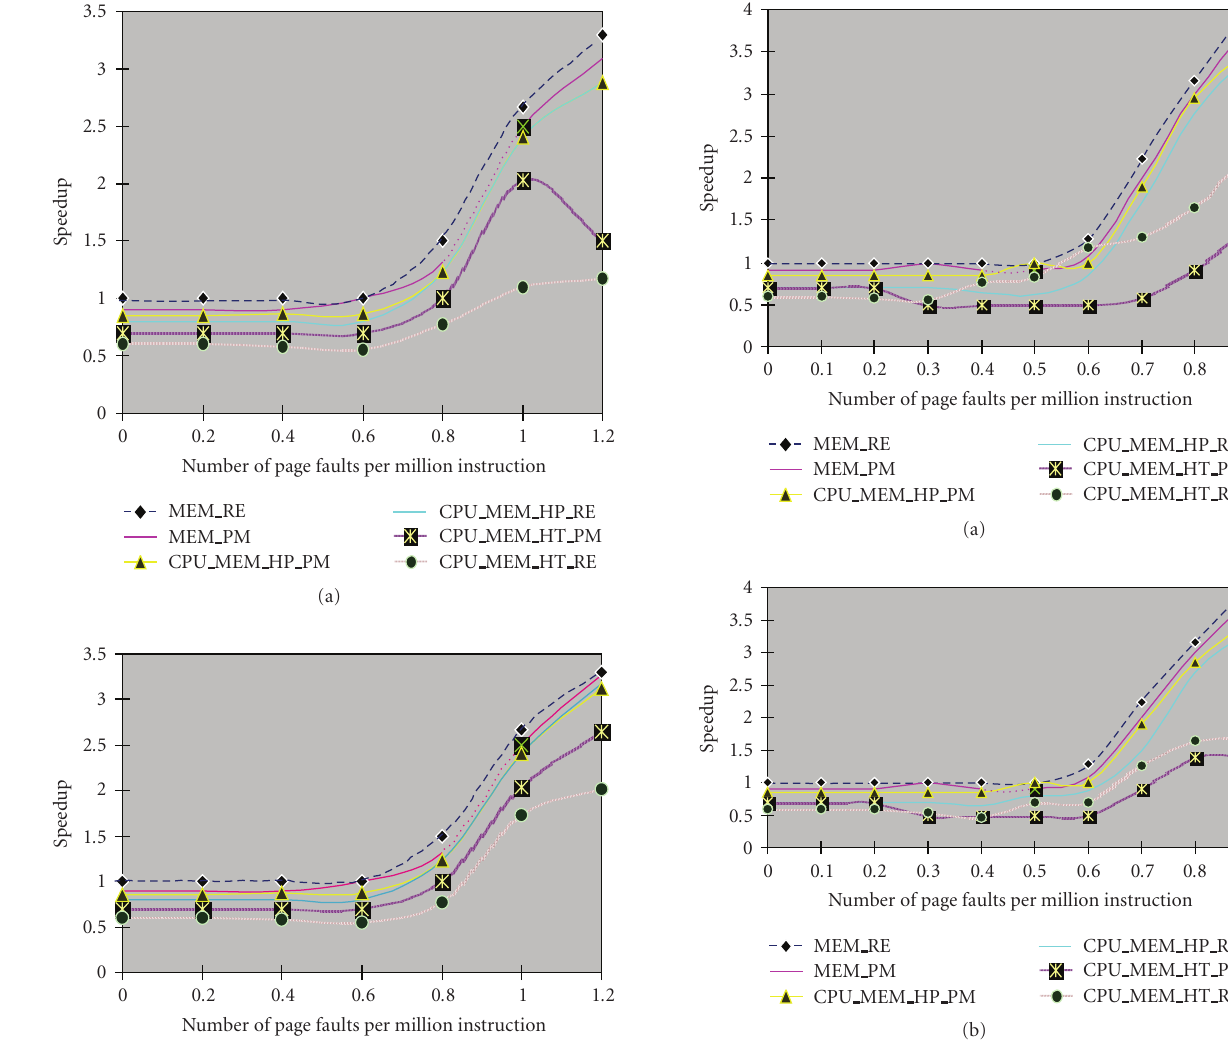
Figure 5: Speedups of the new load sharing policies over CPU PM as the page fault rate increases on “trace 0” with mean memory demand of 13 MB (a) and 14MB